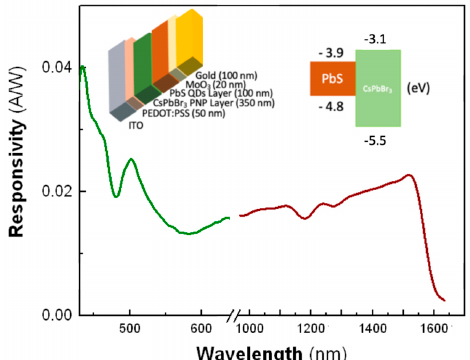
Figure 7. Responsivity curve of the MPA ligand-exchanged PbS quantum dots (QDs)-CsPbBr 3 PNCs heterojunction photodiode. Device architecture is represented in the top inset. The red solid curve represents the extended responsivity range added by the PbS QDs layer while the green solid curve characterizes the responsivity part of the spectrum dominated by CsPbBr 3 PNCs. The gap in between the two curves (800–900 nm) is due to the switching between reference photodiodes: calibrated Si and Ge detectors and different gratings for measuring in visible and near-infrared windows.